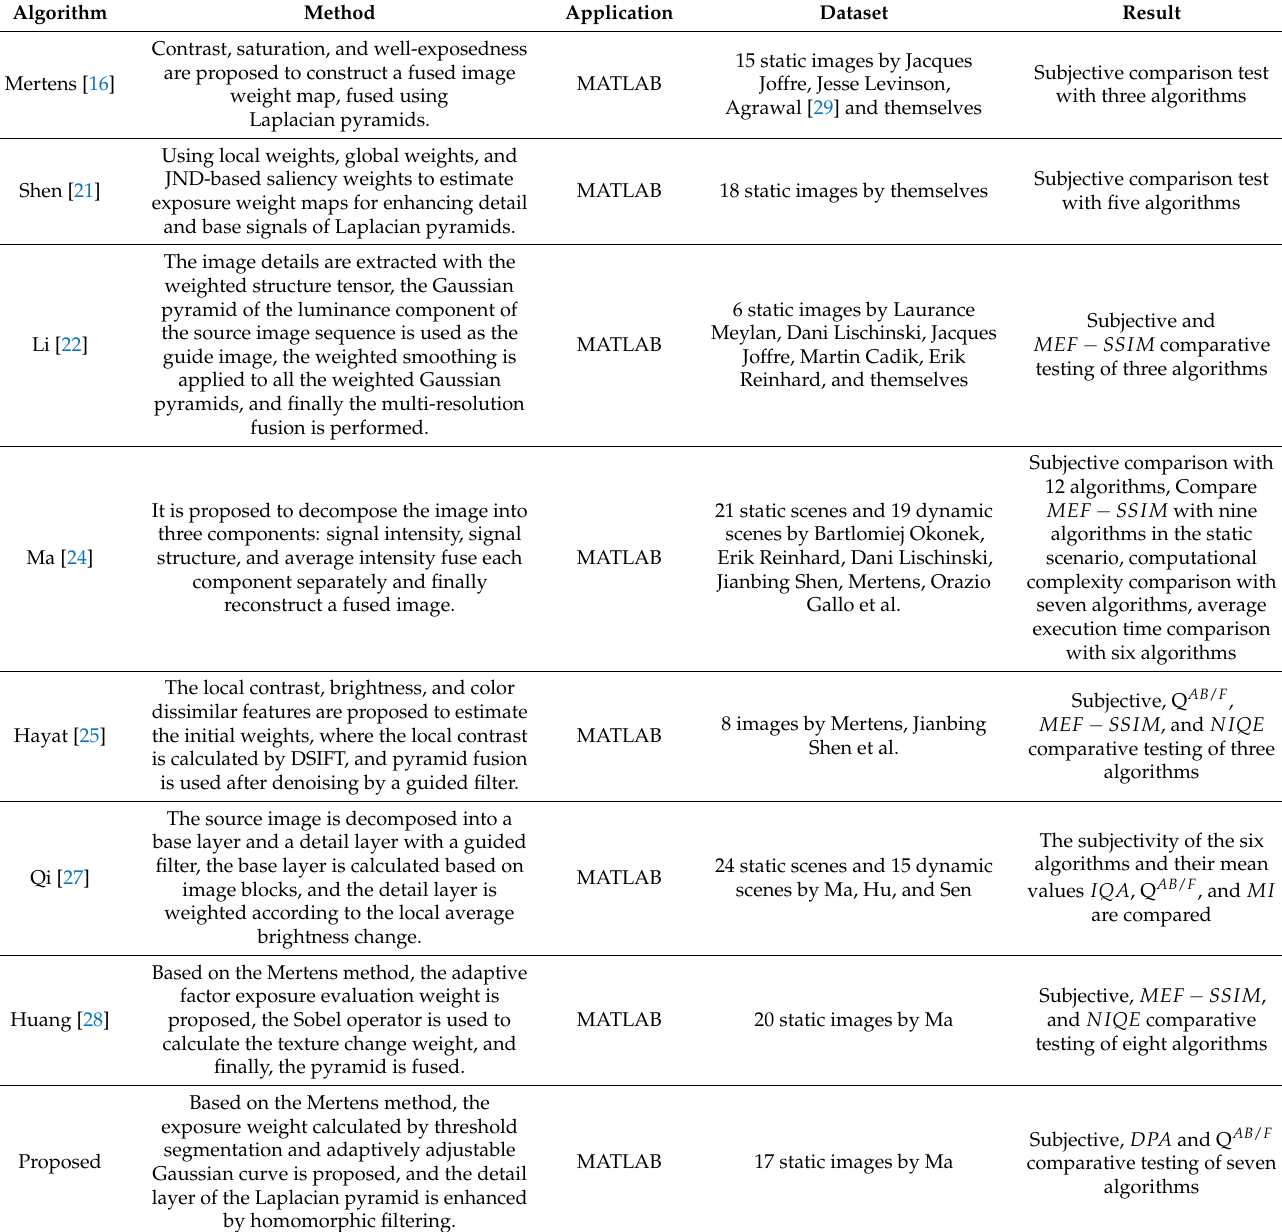
Table 1. Detailed comparison of other